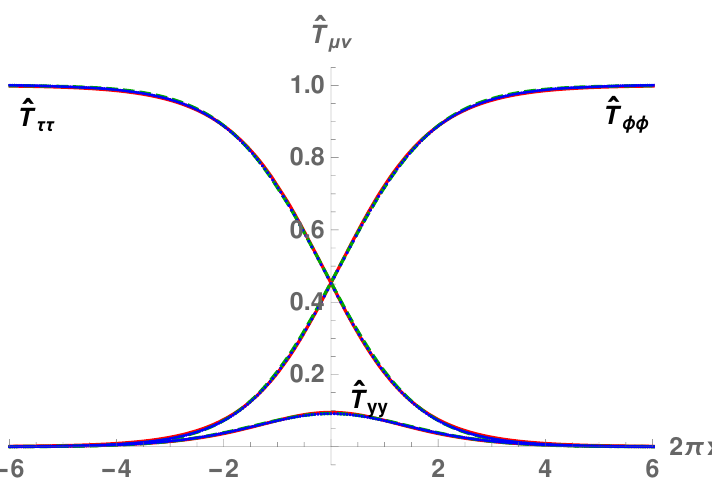
Figure 8 . Final fits of the model to the numerical solution for the domain wall. The blue dots, solid red curve, and dashed green curve show the numerical data, fit using the option A, and fit using the option B,